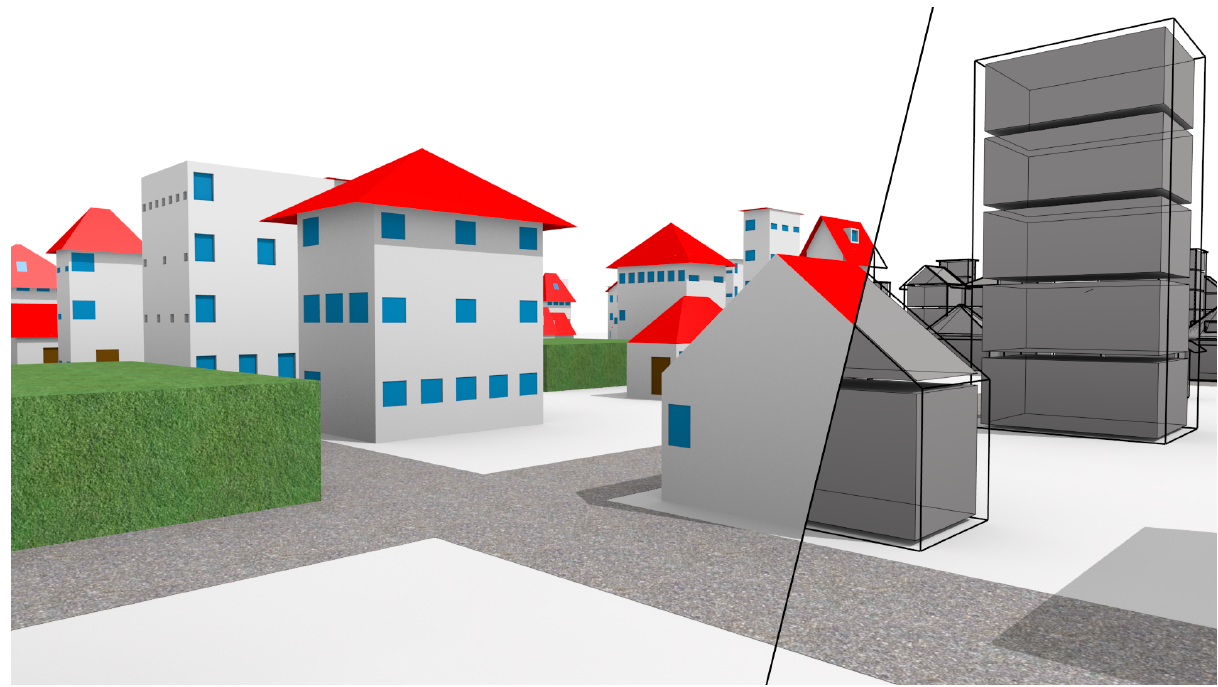
Figure 7: A composite street view of a dataset generated by the engine, showing the vegetation (park), street network, and the basic indoor representation of buildings (a solid representing each storey).